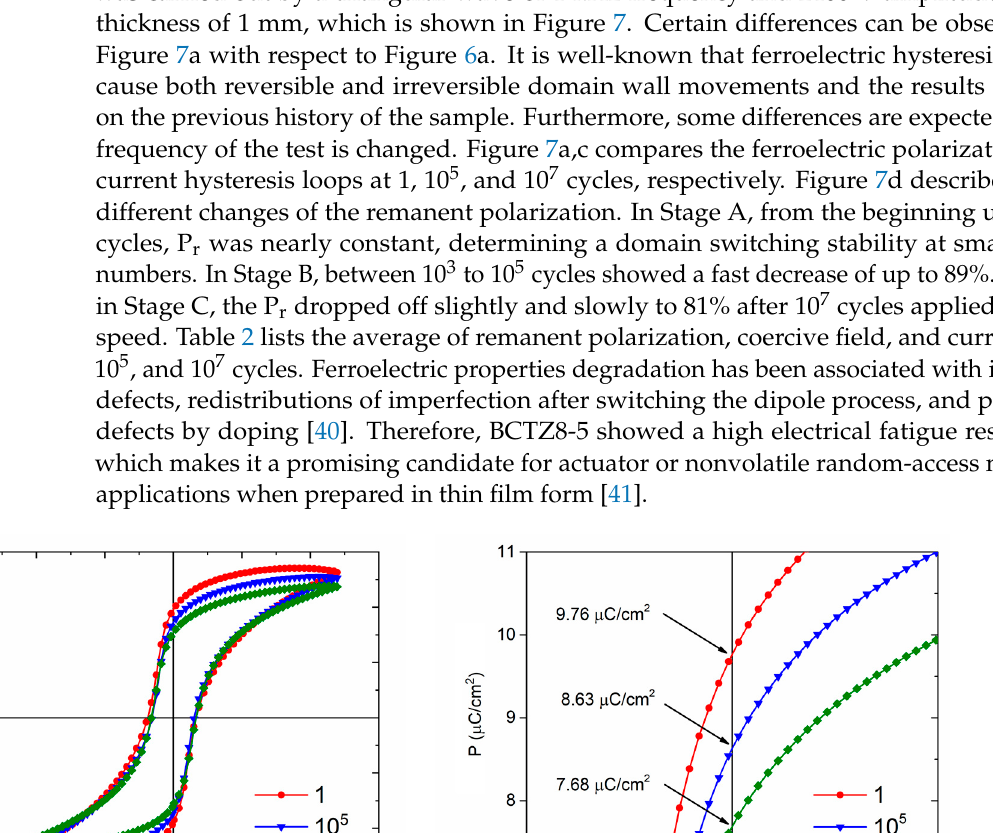
( d ) Figure 7. The changes of ( a ) polarization, ( c ) current, and ( d ) remanent polarization of the BCTZ8-5 sample during different fatigue cycling analyses. ( b ) A magnification of the polarization axis with the different obtained P r values at 1, 10 5 , and 10 7 cycles. Table 2. The average of P r , E c , and I at different fatigue cycling processes for BCTZ8-5. Cycles [n]